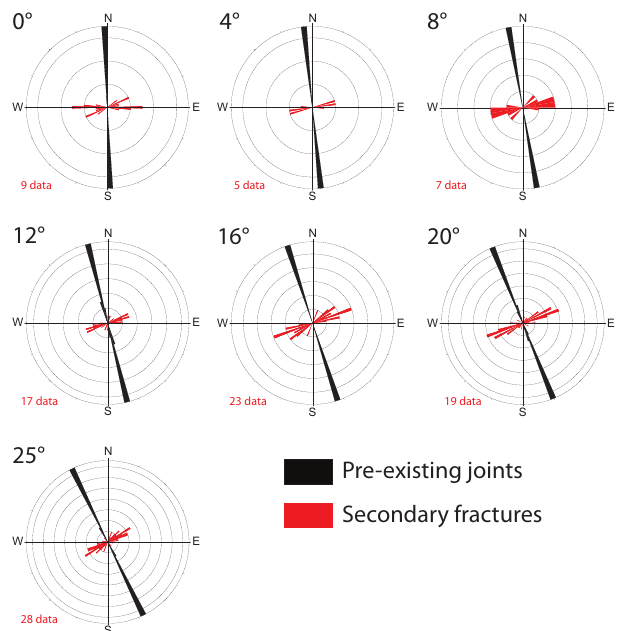
Figure 12. Rose plots showing the orientation of pre-existing joints (black) and secondary fractures (red) for all experiments. Strike di- rection of the basement fault is N–S. Note that secondary fractures are always at a high angle to the pre-exiting joints. Figure 13. PIV images series of the 12 ◦ JF-angle experiment show-